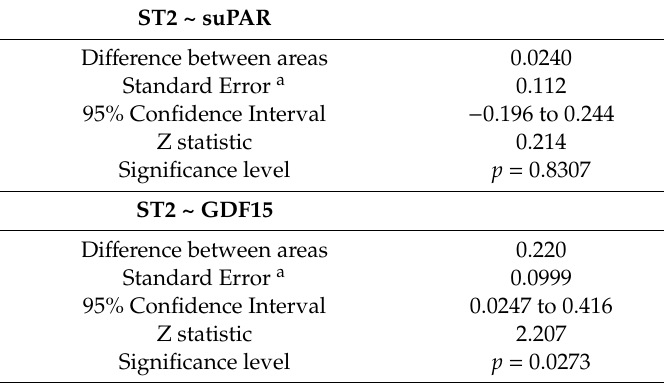
Table 5. Pairwise comparison of ROC